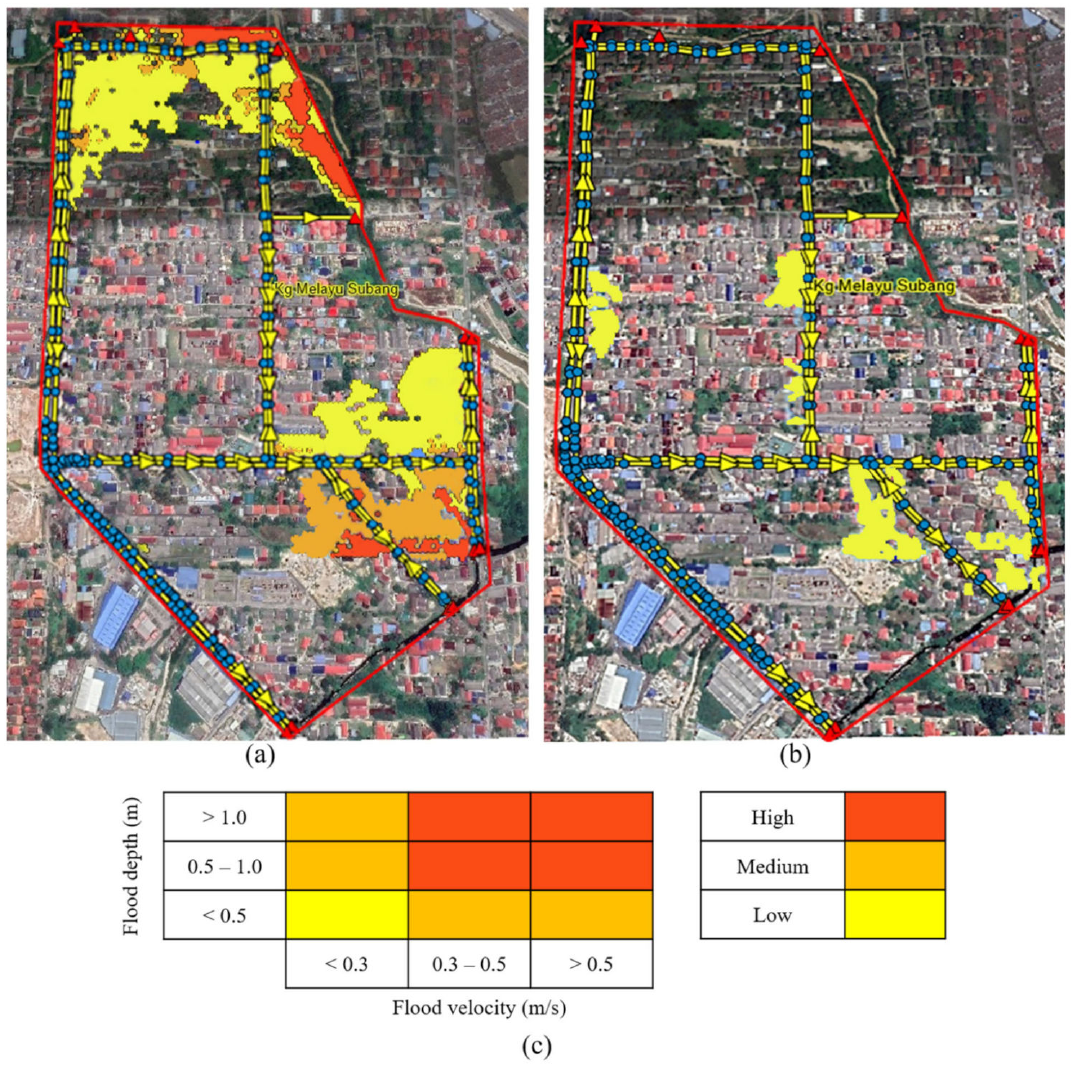
Figure 10. Flood risk mapping for scenarios with ( a ) historic drainage in 2015 (scenario 1) and ( b ) current drainage in 2020 (scenario 2); ( c ) Depth-velocity matrix used in generating the flood risk